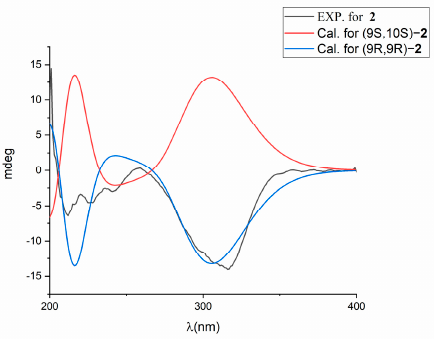
Figure 5. Comparison between the calculated and experimental ECD spectra of